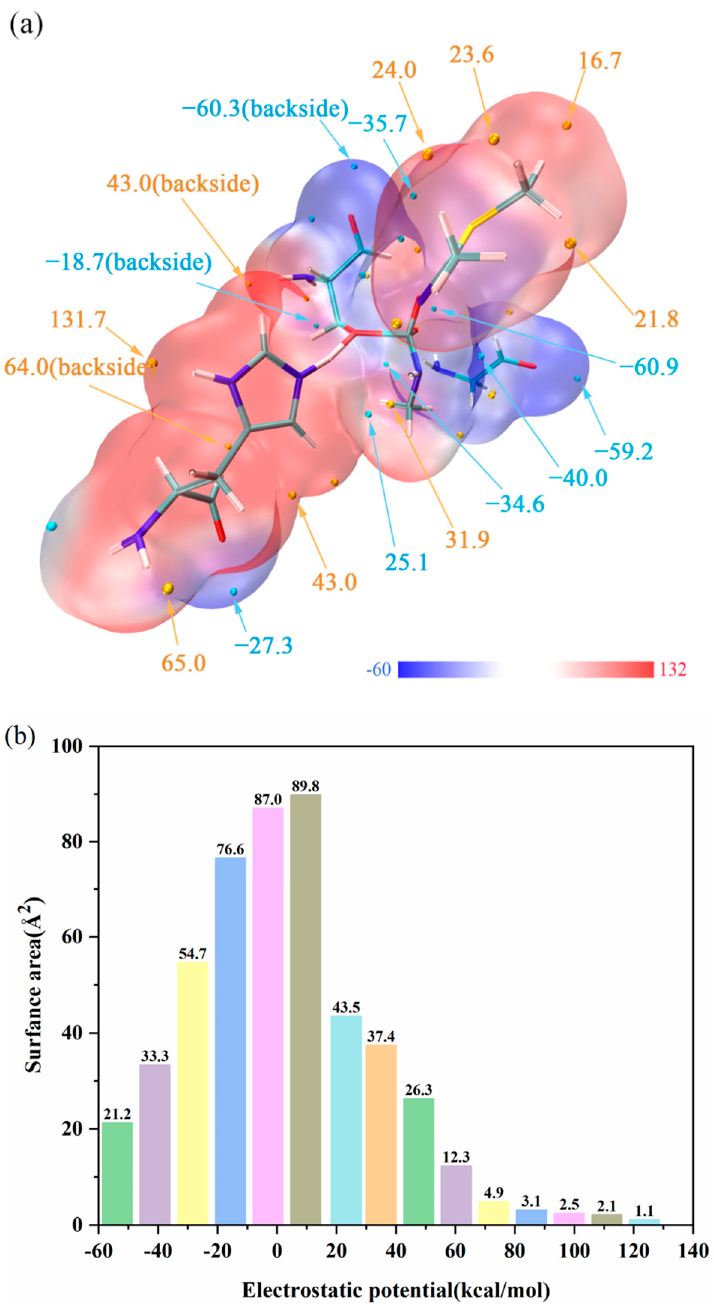
Figure 5. ( a ) ESP distribution on molecular vdW surface of TS1. The unit is kcal/mol, and important surface local minima and maxima of ESP are represented as blue and golden spheres, respectively. ( b ) Surface area in each ESP range on the vdW surface of the system.